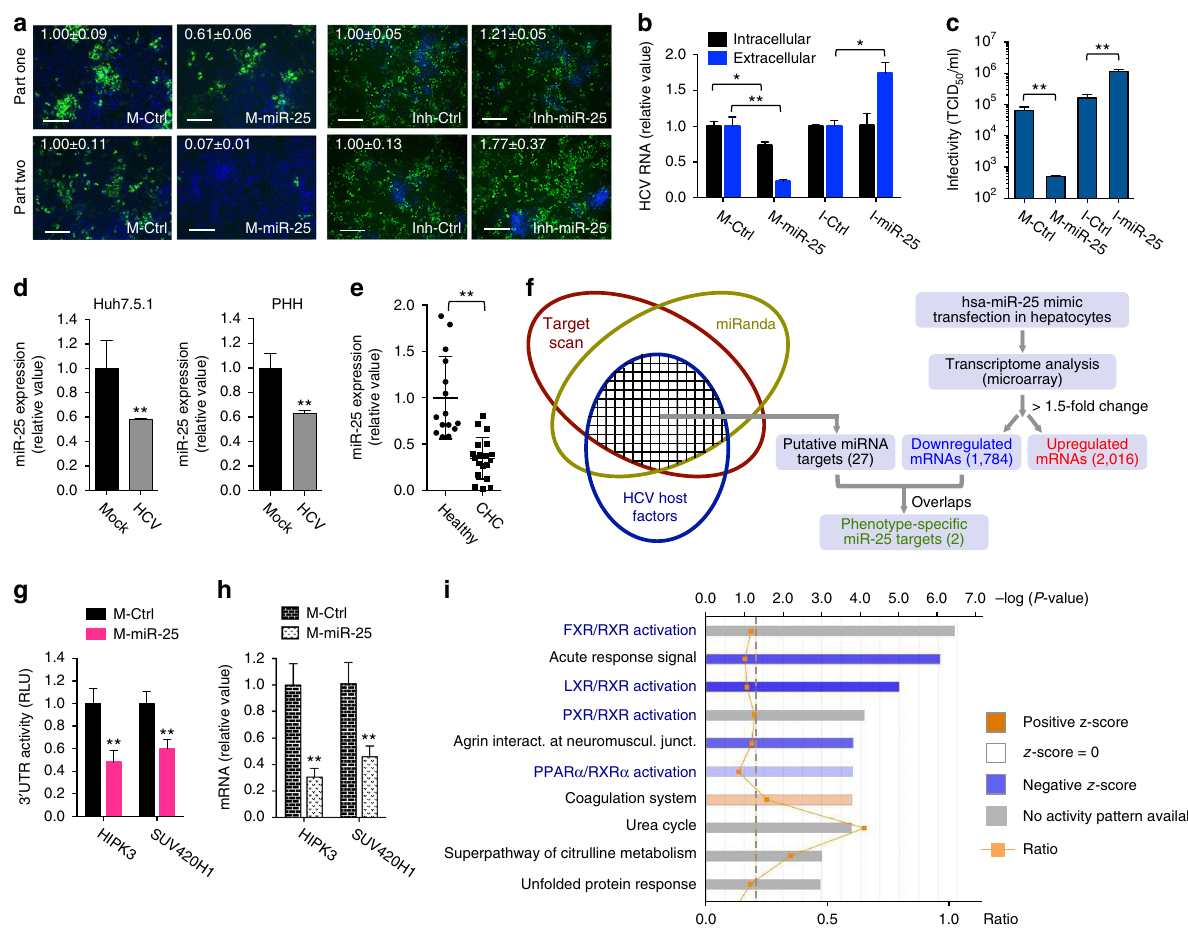
Fig. 4 miR-25 restricts the late stages of HCV infection. a – c Effects of miR-25 mimic or hairpin inhibitor on production of HCV core protein ( a ), viral RNA ( b ), and infectious HCV ( c ). The mimic and inhibitor exerted opposite phenotypes in Huh7.5.1 cells. Compared with part-one core staining ( a ) and intracellular HCV RNA levels ( b ), more profound inhibitory effects were seen in part-two core staining ( a ) and in the level of secreted HCV RNA ( b ). ( a ) Green, HCV core; blue, nuclei. Scale bars, 100 μ m. ( d ) HCV infection downregulates miR-25 expression in Huh7.5.1 cells and PHH, examined by qPCR gene expression assays. e Hepatic abundance of miR-25 is signi fi cantly lower in the livers of CHC patients compared to those of healthy controls, measured by qPCR. Each dot represents one individual ’ s liver tissue. f Schematics for systematic identi fi cation of potential miR-25 targets. Bioinformatics-based target prediction, in line with assessing phenotypic effects on HCV infection and global transcriptome analysis, derived two phenotypic-speci fi c miR-25 target candidates. g , h miR-25 mimic transfection abates 3 ′ -UTR activities ( g ) and mRNA levels ( h ) of HIPK3 and SUV420H1. i Bioinformatics analysis of miR-25 targeted molecular pathways, derived from microarray-based transcriptome dataset comparing miR-25 mimic-transfected cells with mimic control-treated cells (Supplementary Data 7). Ingenuity Pathway Analysis (IPA, QIAGEN) was implemented to analyze all genes signi fi cantly downregulated by miR-25 mimic treatment, identifying various enriched pathways, as shown, that signi fi cantly correlate with miR-25 overexpression. All values are normalized relative to Ctrl, and error bars represent SD of the mean, n = 3 ( a – d , h ) or 5 ( g ). * P < 0.05, ** P < 0.01 determined by Student ’ s t ( > 300 counts) or moderately expressed miRNAs (50 – 300 counts) were downregulated by more than 2-fold upon HCV infection.